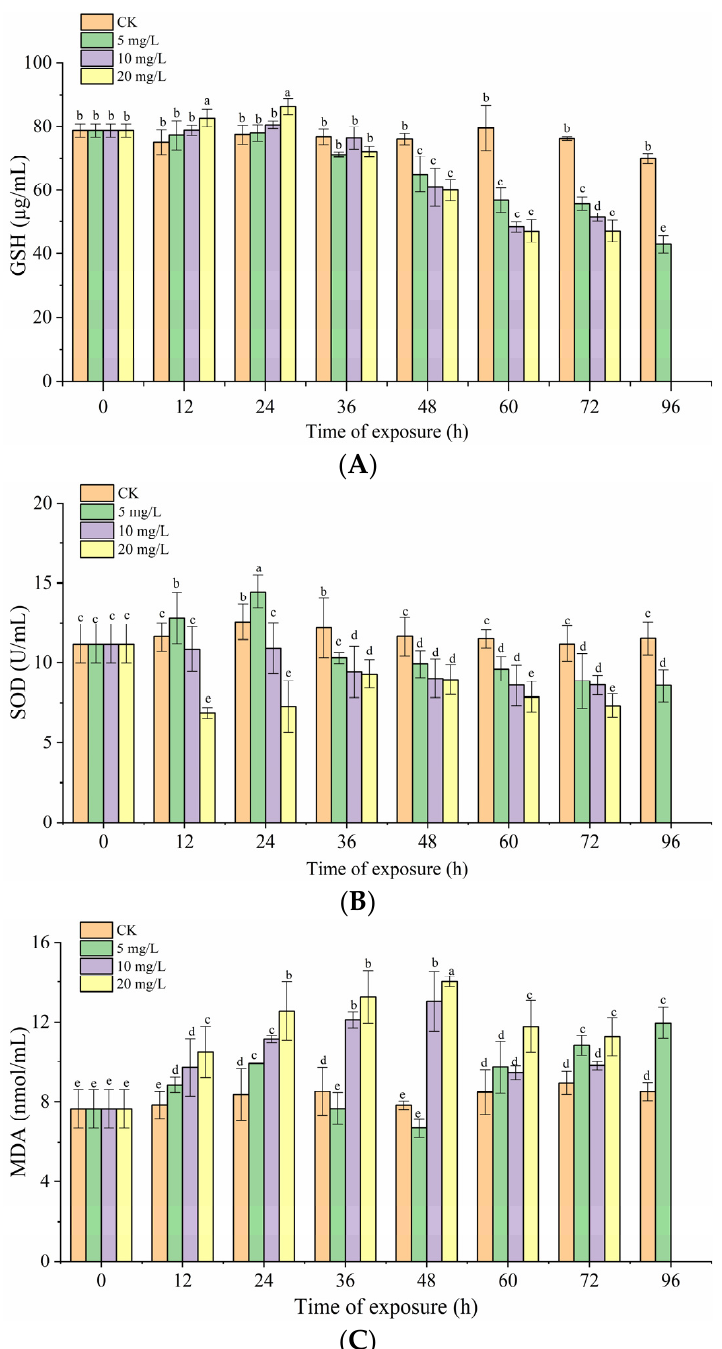
Figure 3. Changes in antioxidant capacity ( A ) GSH, ( B ) SOD, and ( C ) MDA levels in pearl gentian grouper exposed to various nitrite concentrations over 96 h. Data are means ± SD. Different lowercase letters indicate that there are significant differences among groups ( p < 0.05).